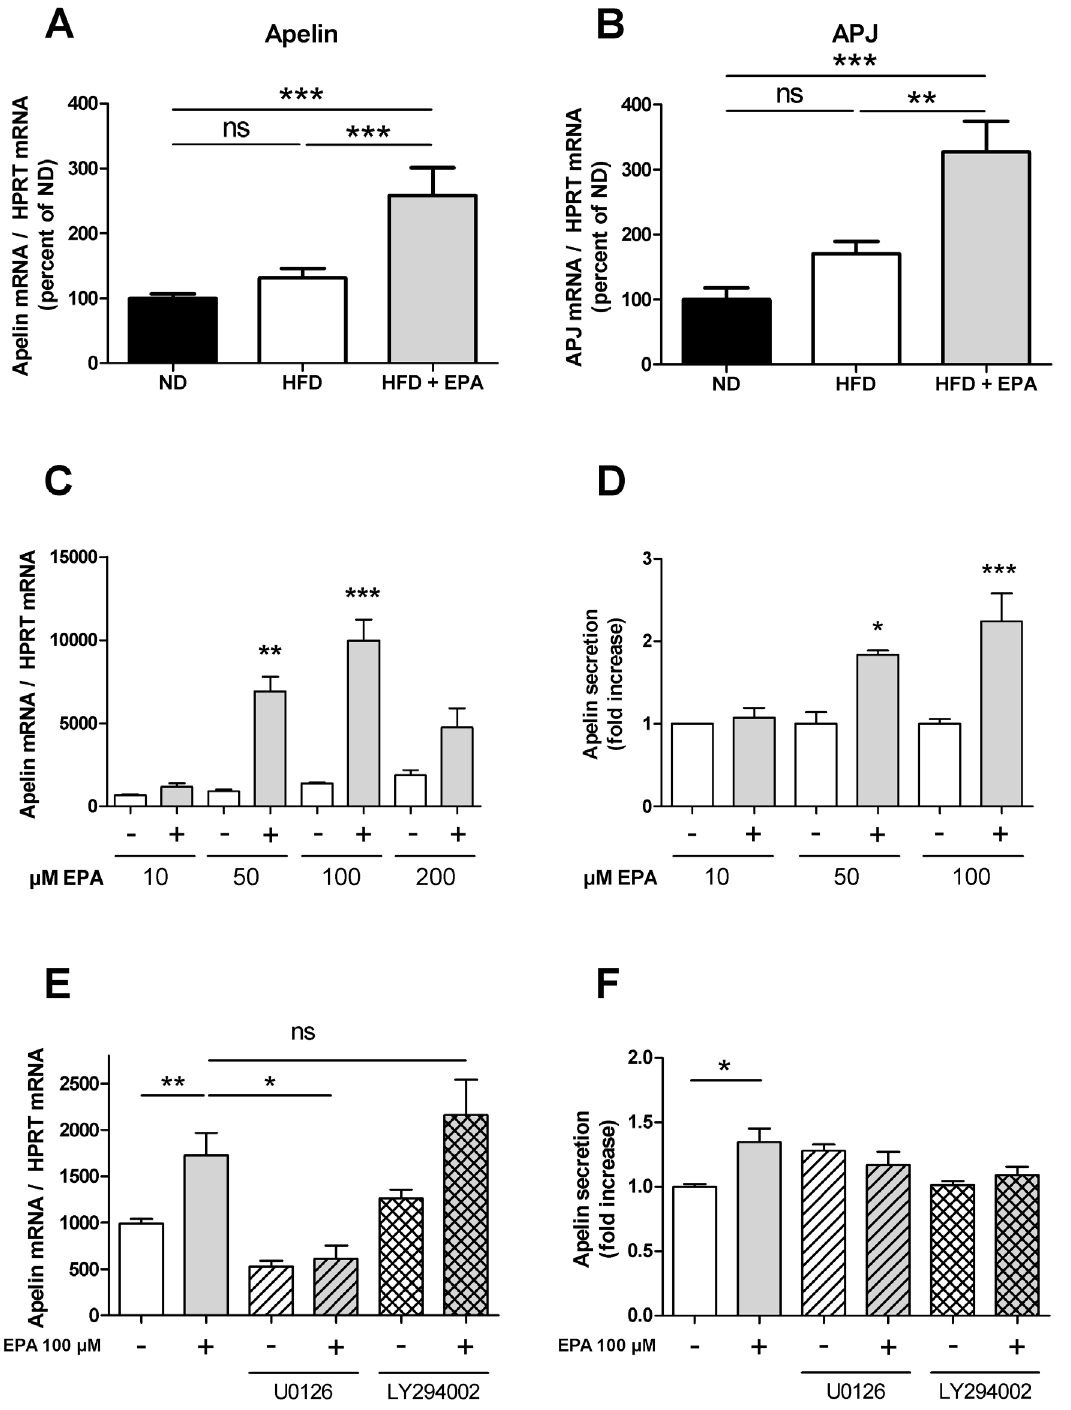
Figure 6. EPA induces in vivo and in vitro expression of the apelin/APJ system in muscle. (A) Apelin and (B) APJ mRNA expression in soleus muscle of ND (n=7), HFD (n=10) and HFD + EPA (n=5). Results represent mean 6 SEM **p , 0.01, ***p , 0.001, ns: not significant. (C) Apelin mRNA expression and (D) secretion in differentiated C2C12 cells treated with the indicated EPA concentrations or the corresponding BSA content for 24 hours after 12-hour serum deprivation. Data are mean 6 SEM n=4–5 in each condition. *p , 0.05, **p , 0.01 ***p , 0.001. (E) Effect of 100 m M EPA in the absence or in the presence of the PI3K inhibitor LY294002 (20 m M) or the ERK 1/2 inhibitor U0126 (20 m M) for 24 h after 12-hour serum deprivation on apelin mRNA expression and (F) secretion in differentiated C2C12 cells. Results represent mean 6 SEM (n=4–5 in each condition) *p , 0.05, **p , 0.01, ns: not significant.